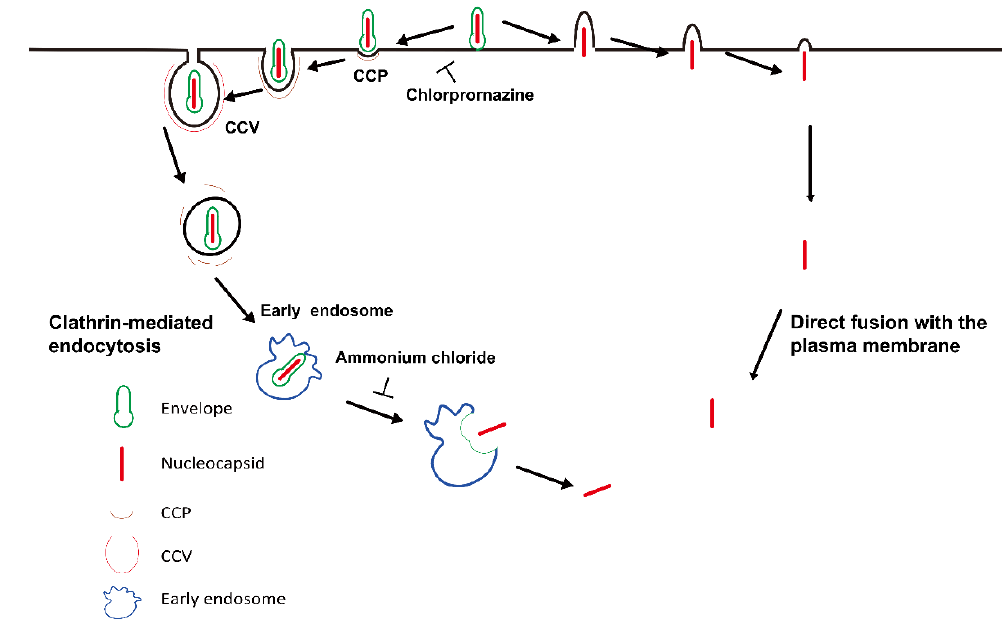
Figure 7. A proposed model for AcMNPV cell entry via clathrin-mediated endocytosis and direct fusion with the plasma membrane . AcMNPV particles first attached to the cell surface. They were then predominantly captured by pre-formed CCPs, and further invaginated to form virus-bearing CCVs. Inhibition of CCP assembly with CPZ significantly blocked viral internalization. After invagination into the cytoplasm, the CCVs were gradually disassembled and delivered to early endosomes. The virus-bearing endosomes underwent acidification, and the nucleocapsids were then released into the cytosol. When endosomal acidification was inhibited with ammonium chloride, the virus particles were blocked out of the endosomes. Importantly, a minority of virus particles fused directly with the plasma membrane. After viral envelope fusion with the plasma membrane, the nucleocapsid was directly released into the